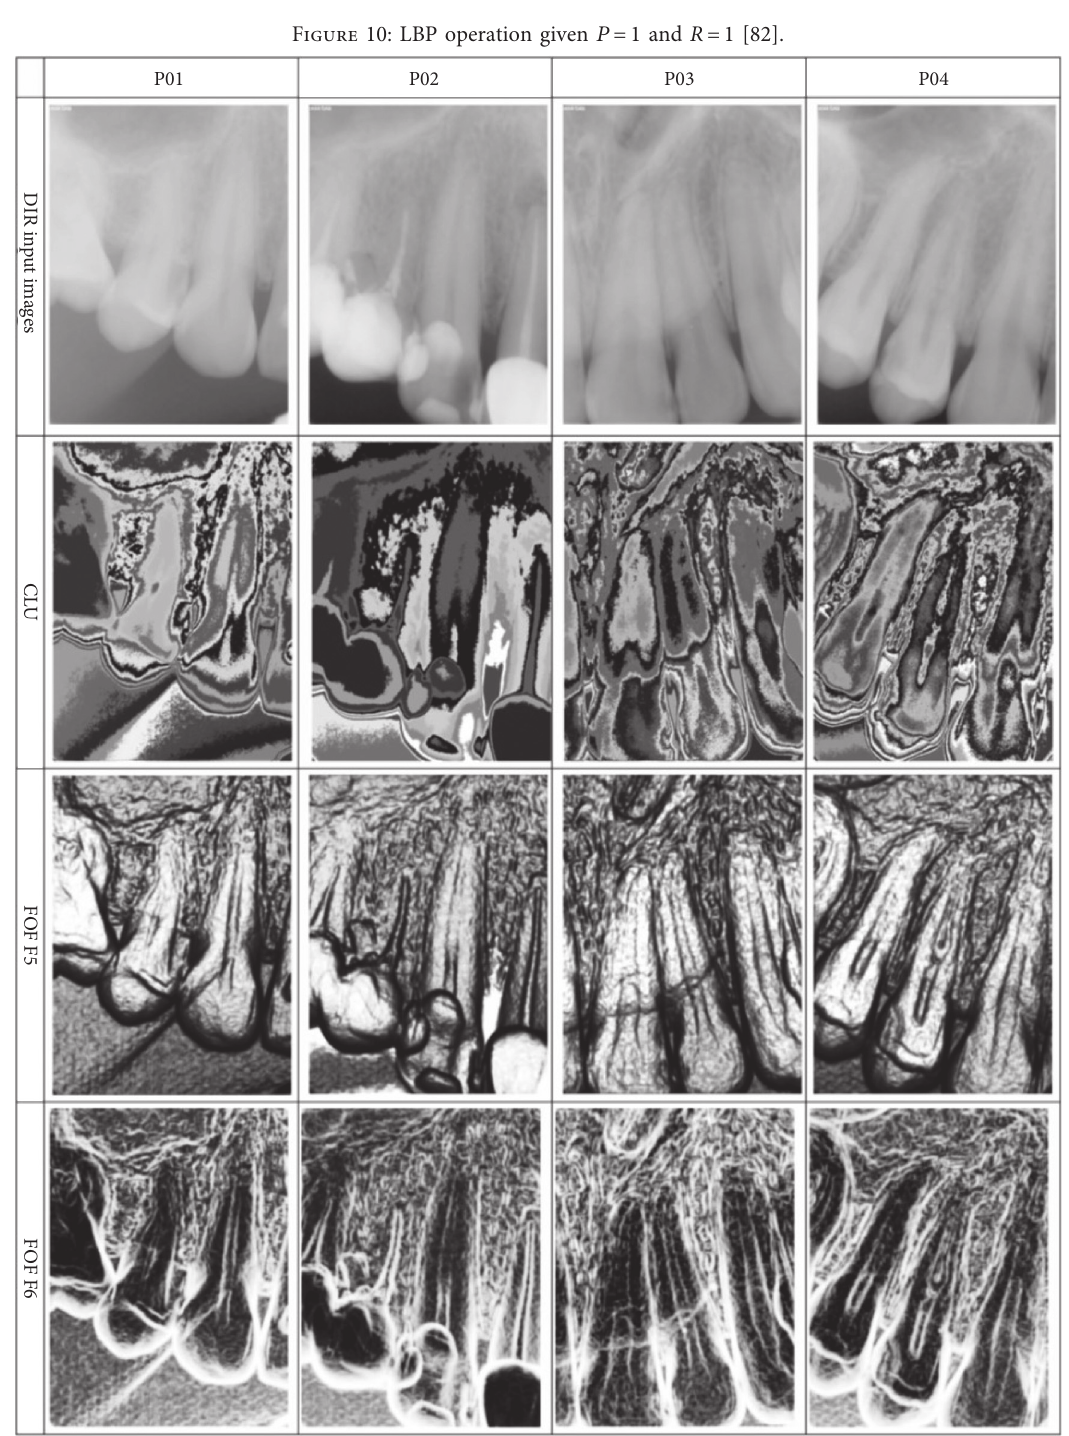
Figure 11: Intraoral radiographs texture feature maps